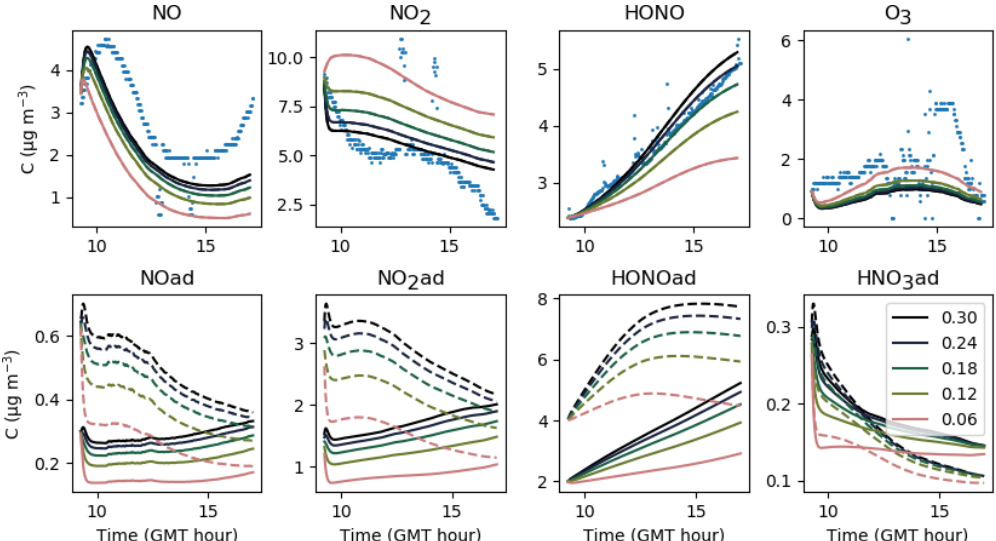
Figure 10. Gas-phase and adsorbed inorganic compounds simulated with different u inf . The blue dots denote the experimental measurements (Experiment 3). The solid lines represent the concentrations in the sunlit box and the dashed lines the concentrations in the shaded box.